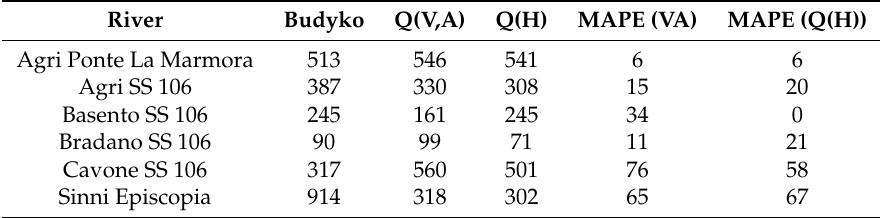
Table 6. Comparison of the mean annual volume of discharges obtained using the extracted flow-rating curves with the two proposed approaches and the expected volumes obtained using the Budyko model for 2012.